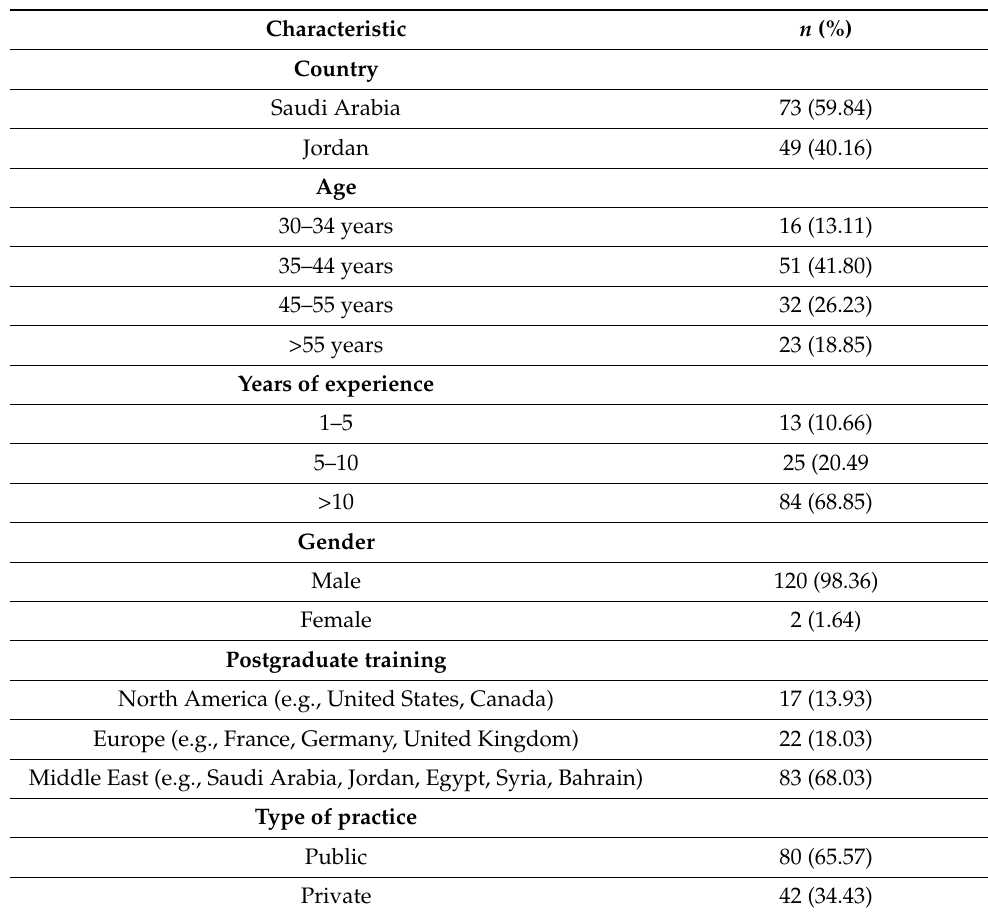
Table 1. Baseline characteristics of the participants ( n =